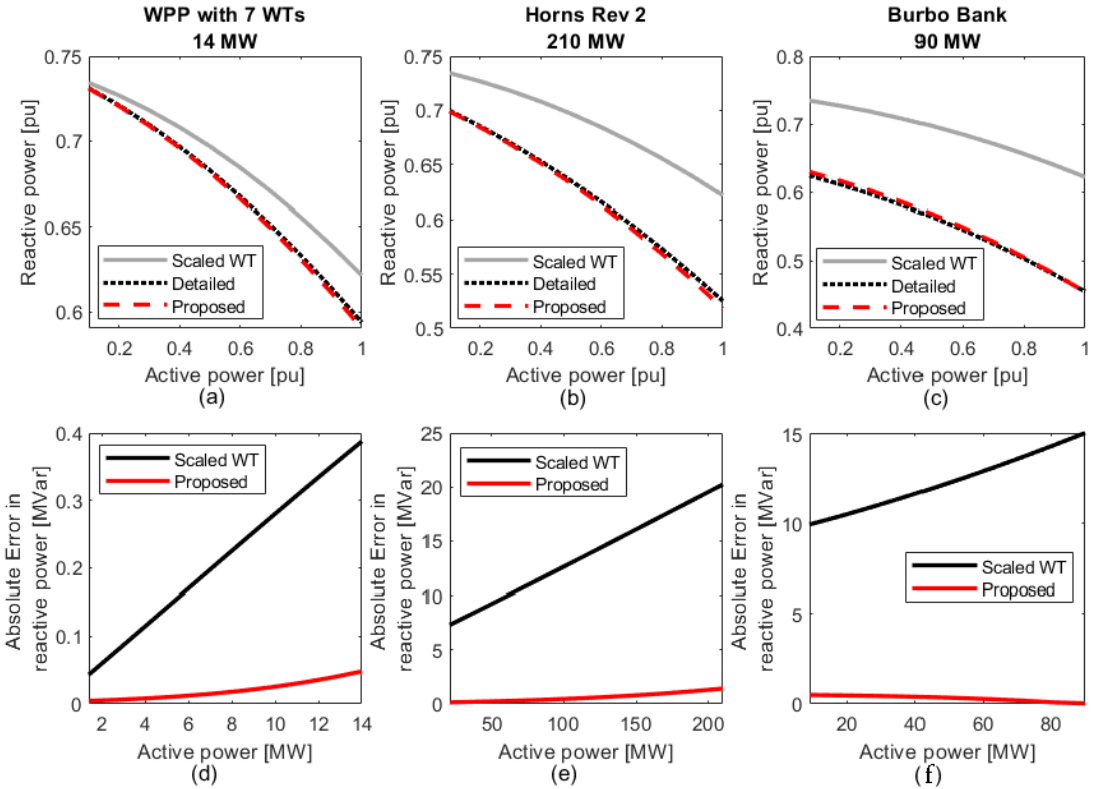
Figure 11. ( a – c ) WPP reactive power capability estimation using different models at 1 p.u. voltage at LV side of WPP transformer. ( d – f ) Error in WPP reactive power capability estimation using scaled WT model and the proposed model compared to detailed WPP